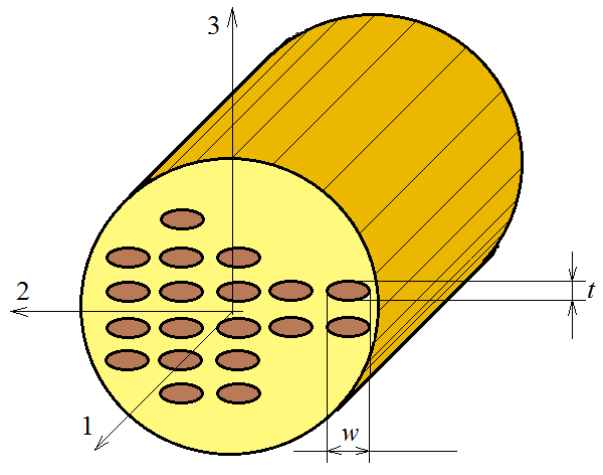
Figure 5. Reinforced composite.